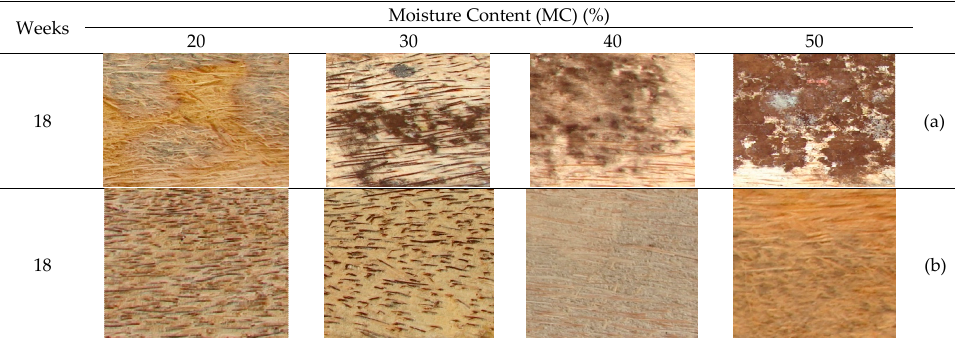
Figure 5. The surface color of oil palm lumber immersed in sea water and Dursban 4E for 48 h. ( a ) The result indicated that in week 18, oil palm specimens at 20% MC immersed in sea water only for 48 h and thereafter conditioned in a kiln, exhibited a significant discoloration which increased with an increased in percentage MC in the oil palm specimens. ( b ) Whereas those specimens immersed in sea water for 48 h, followed by immersion into Dursban 4E for 48 h, and thereafter conditioned in a kiln to varying MCs did not exhibit any discoloration (Figure 5). The oil palm tree trunk is very hygroscopic, which means it shrinks and swells easily upon the loss and gain of water, respectively. This hygroscopic property could improve the absorption of water, which could result in the removal of some sap to give way to the entrance of the preservative material during immersion to crystalize the sugar and render it poisonous to the deteriorating organisms. Comparatively, specimens immersed in sea water only for 48 h, and thereafter con- ditioned in a kiln to varying moisture contents at a thickness of 40 mm showed visible discoloration at all the MC levels. Specimens immersed in sea water for 48 h, followed by immersion into Dursban 4E for 48 h, and thereafter conditioned in a kiln to varying mois- ture contents at a thickness of 40 mm showed no visible discoloration at any of the MC levels (Figure 5). However, oil palm lumber specimens of 40 mm thick immersed in Durs- ban 4E for 48 h and conditioned in a kiln to a moisture content of 30% discolored from week 2. Legend A: The surface color of oil palm specimens immersed in sea water only for 48 h, and thereafter conditioned in a kiln to varying MCs at a thickness of 40 mm. Legend B: The surface color of oil palm specimens immersed in sea water for 48 h, followed by immersion into Dursban 4E for 48 h, and thereafter conditioned in a kiln to varying MCs at a thickness of 40 mm. Oil palm logs, and for that matter, oil palm lumber, attract infestation of both insects and fungi fairly quickly (some even happened overnight) when they are left in the field or even under cover (personal observations by the authors). The high susceptibility of oil palm stems and boards to infestation by both fungi and insects is due to the presence of high sugar and starch in the parenchyma cells [51,52]. Thus, the lumber should immedi- ately be immersed into pure water after being sawed, before preservatives are applied. [47] concluded in their study on the anatomical characterization and utilization of oil palm wood that oil palm wood from the outer zone of the trunk provides the best properties.